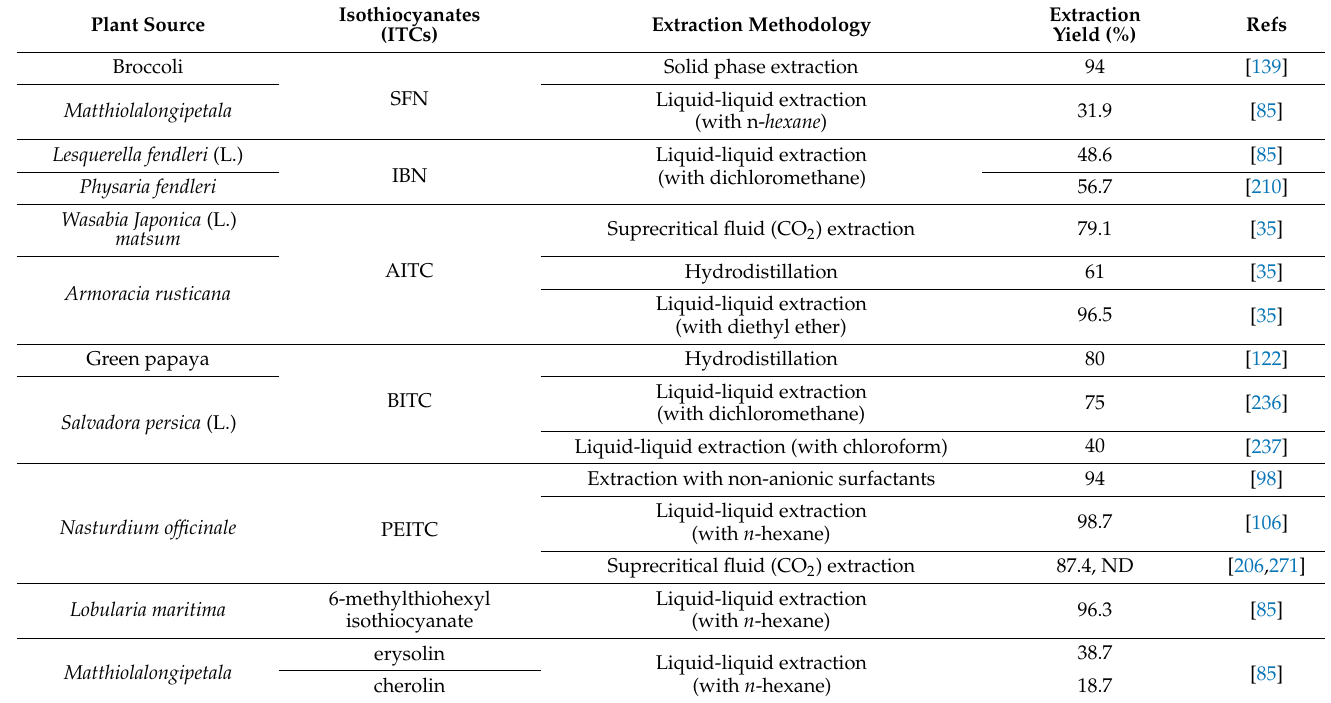
Table 4. Optimum conditions for the extraction of ITCs from naturally-derived